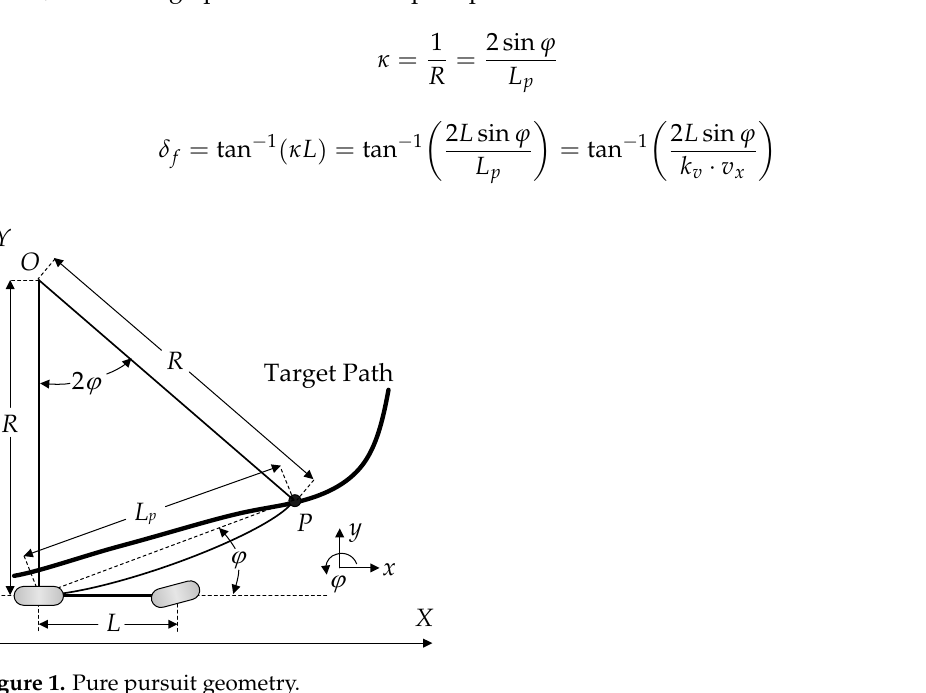
Figure 1. Pure pursuit